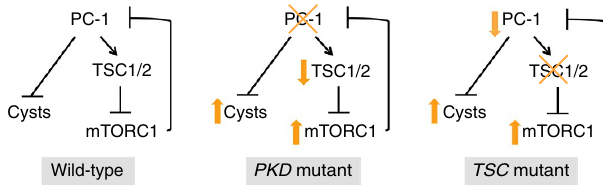
Figure 6 | Proposed model of cross regulation of the PKD and TSC genes. Schematic summary of the proposed model. PC-1 inhibits the mTORC1 pathway by acting on the TSC genes (previous work 3,4 ), whereas mTORC1 acts in a negative feedback loop to